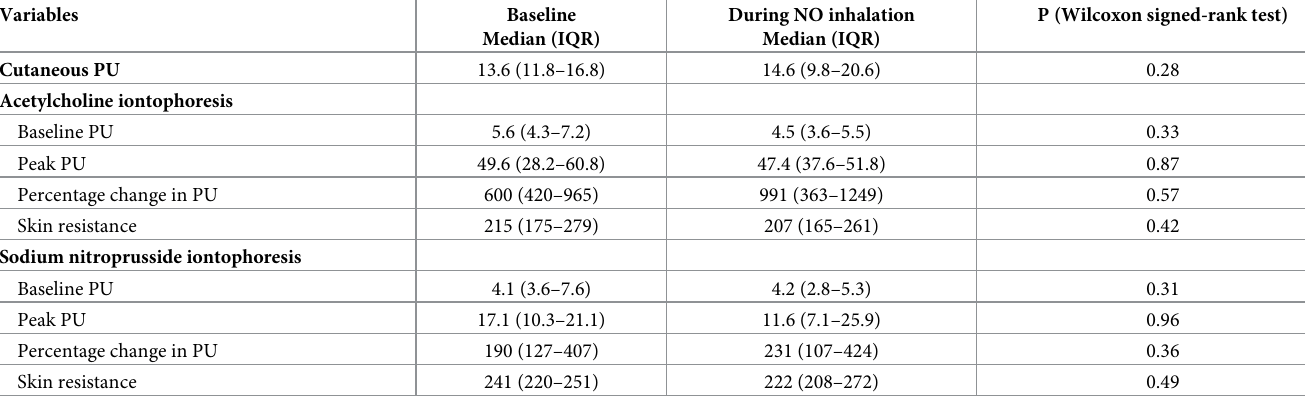
Table 2. Forearm microvascular studies at baseline and during NO inhalation.